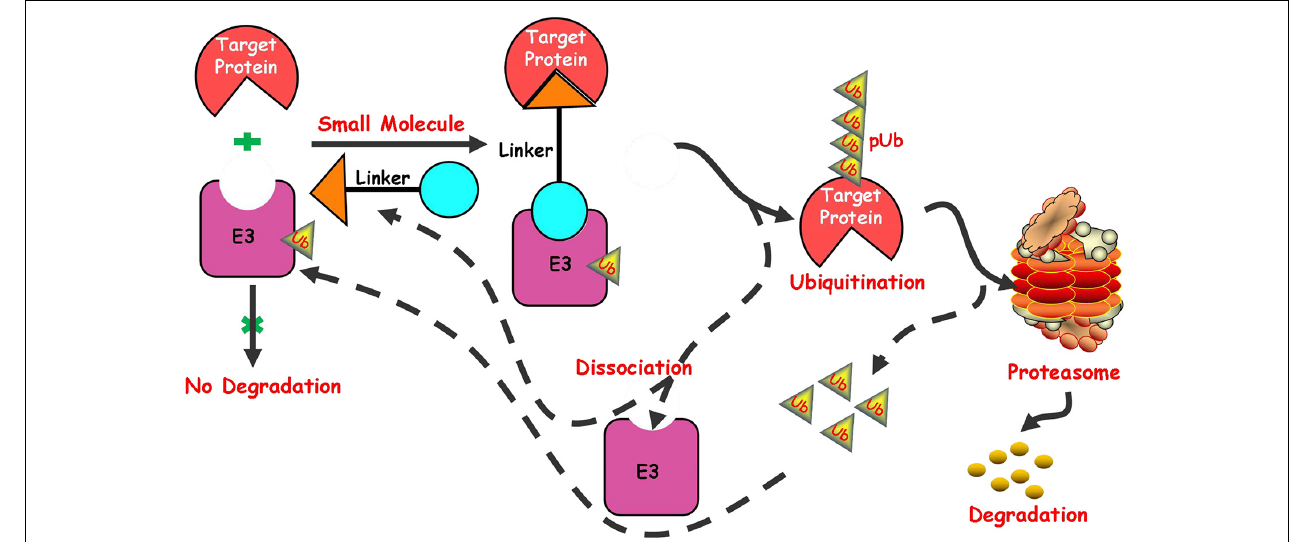
FIGURE 1 | Schematic depiction of the small molecule induced protein